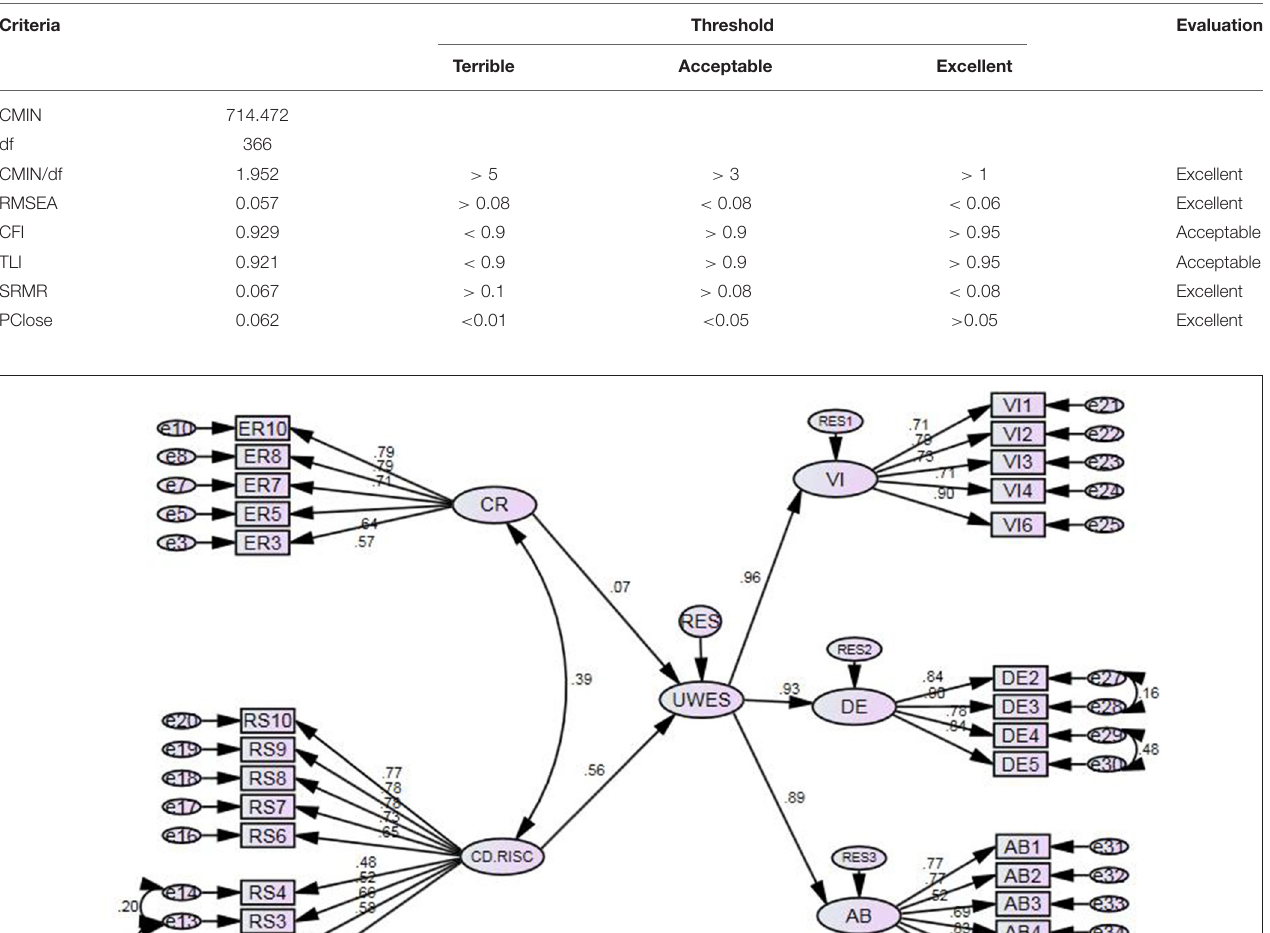
TABLE 3 | Goodness of Fit Indices.